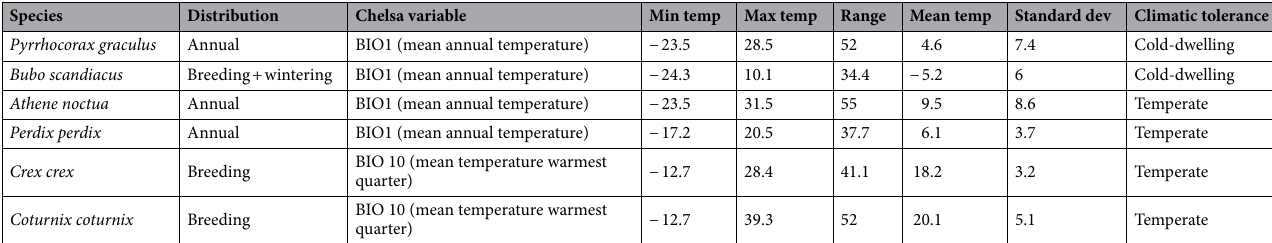
Table 1. Species thermal indexes of the six bird species object of the work. The STI is identified with the average temperature experienced by a species across its distribution (i.e., mean temperature) and defines the climatic tolerance of